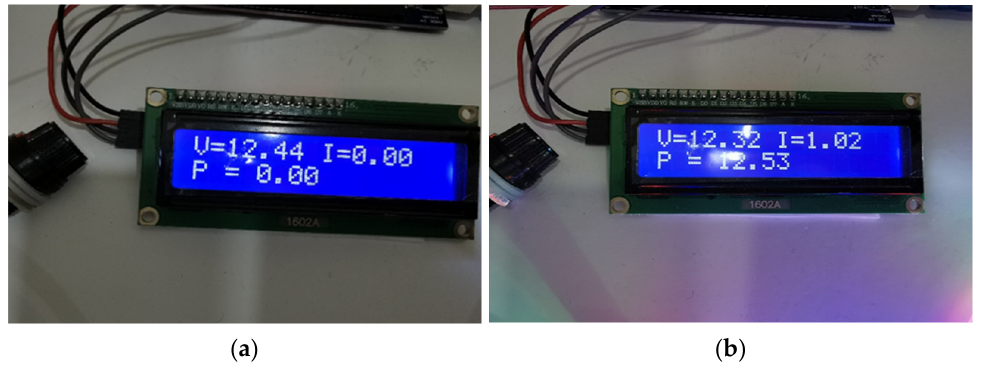
Figure 8. Measured data. ( a ) Without and ( b ) with connected load.